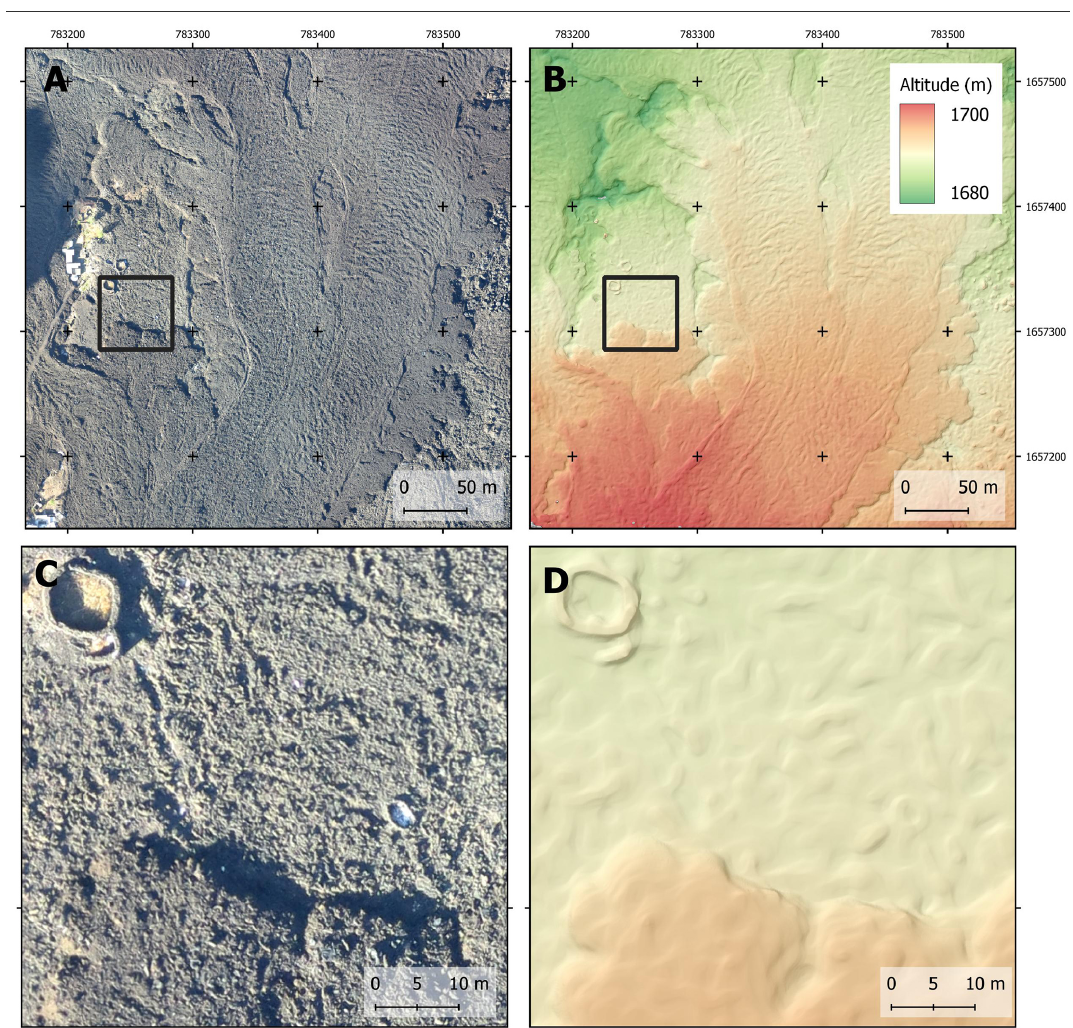
Figure 15. Examples of the quality of the orthomosaic and DSM of the Chã das Caldeiras in an area of an ‘a‘¯a lava flow, showing also a circular wall structure. ( a , c ) Orthomosaic (10cm). ( b , d ) Hill shade model over DSM